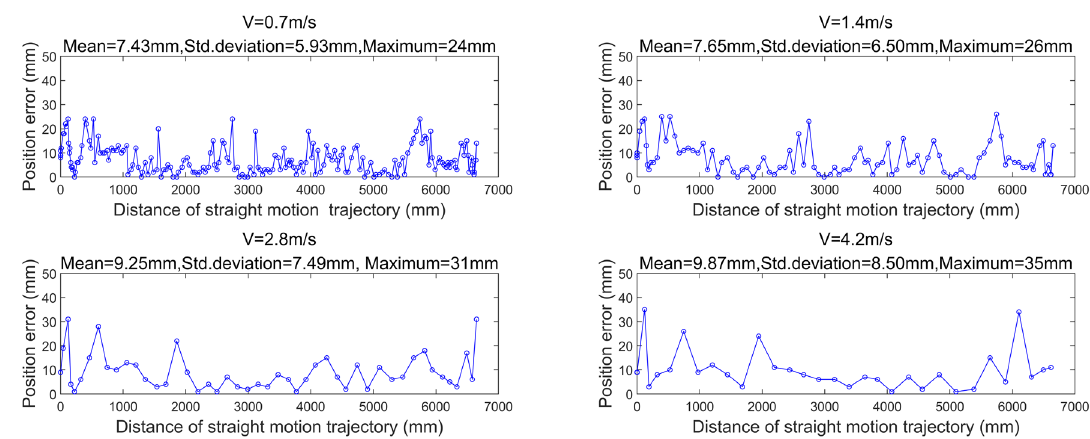
Figure 10. Localization accuracy at different speeds.